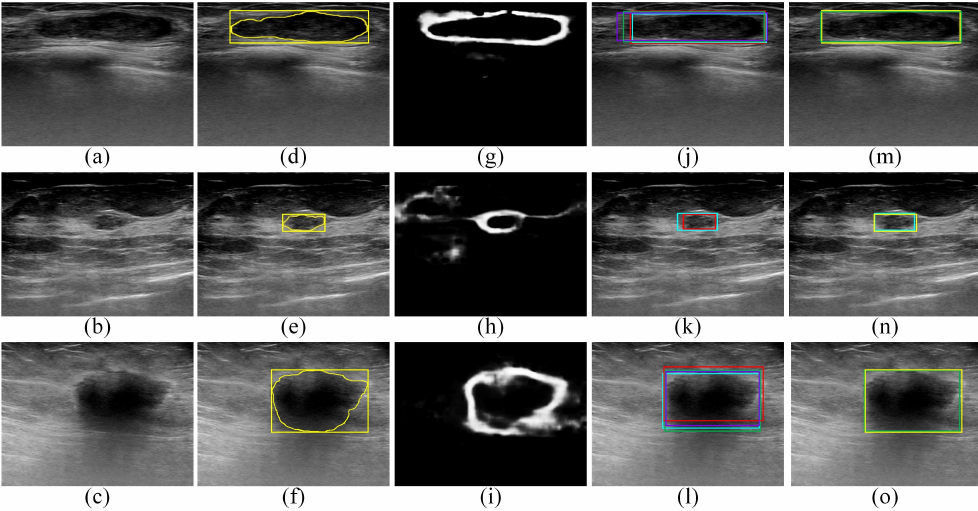
Figure 5. Qualitative results obtained for the UJH dataset. ( a – c ) BUS images acquired for ( a ) benign tumor and ( b , c ) malignant tumors. ( d – f ) The gold standard tumor outlines (yellow outlines) and the gold standard ROIs (yellow boxes) overlaid on the BUS images. ( g – i ) The edge maps com- puted using the DexiNed model. ( j – l ) The ROI localizations generated by the Faster R-CNN (violet boxes), SSD (red boxes), EfficientDet-D0 (cyan boxes), and CenterNet (green boxes) models overlaid on the BUS images. In ( k ), the Faster R-CNN and CenterNet models failed to generate ROIs. ( m – o ) The ROIs selected by the proposed edge-based selection method as well as the gold standard ROIs (yellow boxes) overlaid on the BUS images. In ( m – o ) the proposed edge-based selection method selected the ROIs generated by the CenterNet, EfficientDet-D0, and CenterNet models,